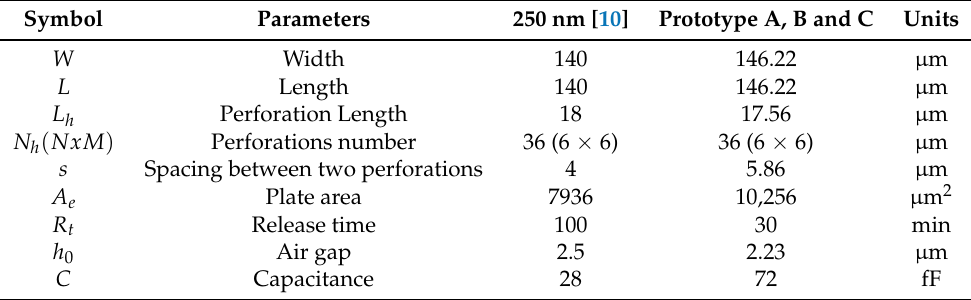
Table 2. Summary of common parameters in the structural design of prototypes.